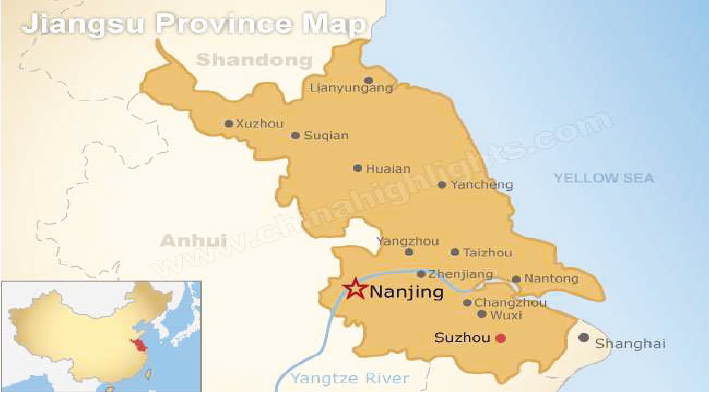
Figure 1: Geographical location of Nanjing, China